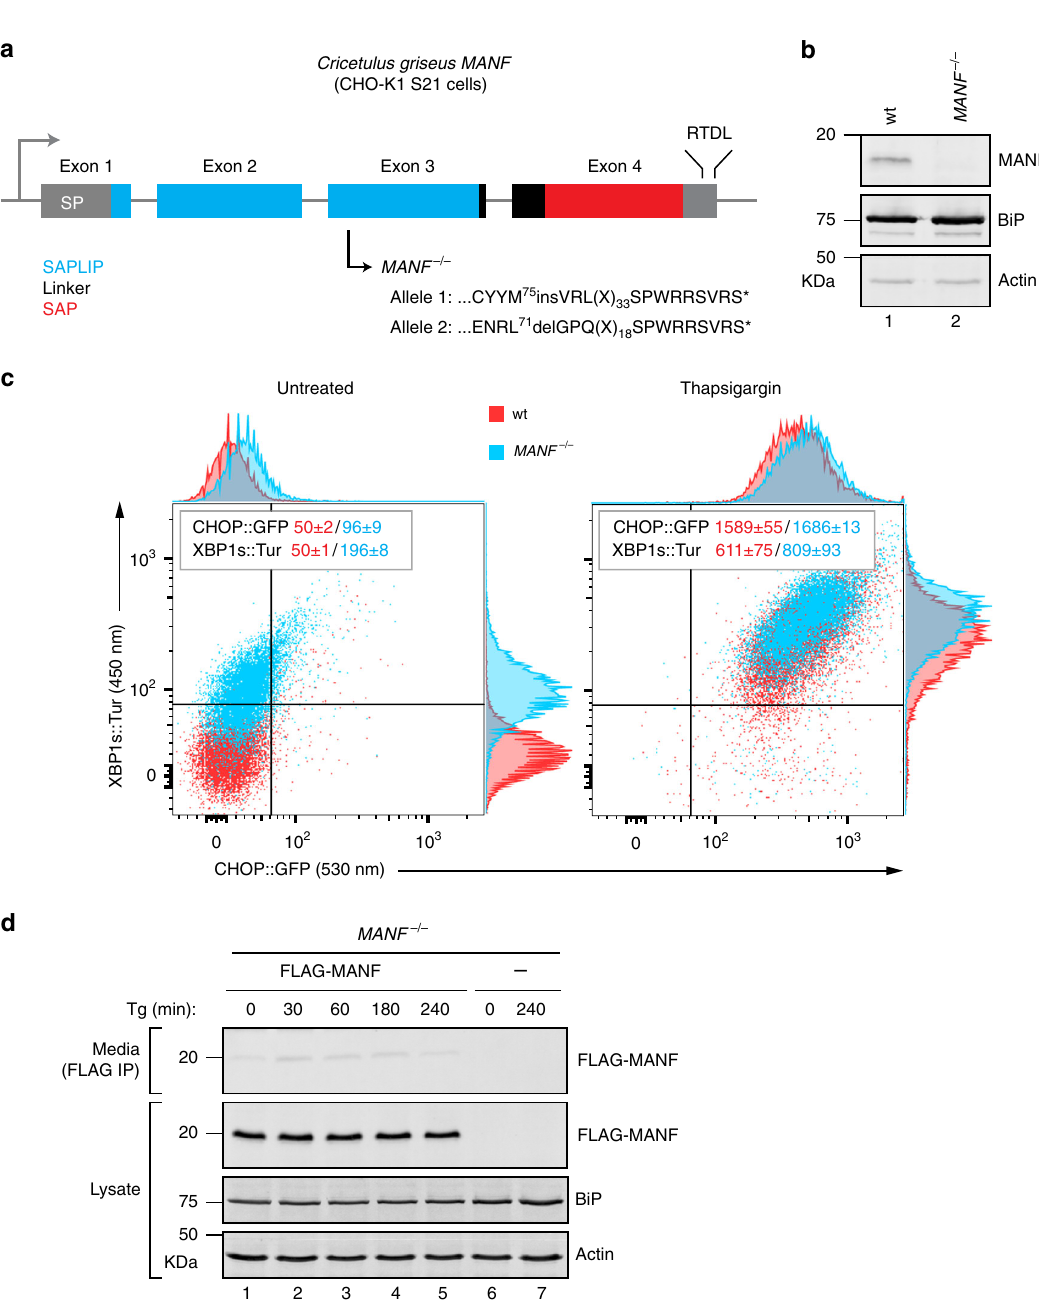
Fig. 1 A heightened UPR in MANF knockout cells. a Schematic illustration of the CHO-K1 MANF gene. The encoded N-terminal SAPLIP (Saposin-like protein; blue) and the C-terminal SAP (SAF-A/B, Acinus, and PIAS; red) domains as well as the signal peptide (SP), linker region (black), and RTDL motif are shown. The encoded amino acid sequence surrounding the mutations (caused by CRISPR-Cas9-mediated nucleotide insertion or deletion) are noted for each allele. Both mutations result in premature termination of translation interrupting the SAPLIP domain and deleting the SAP domain. b Immunoblot of MANF in lysates of CHO-K1 S21 wild-type (wt) and MANF − / − cells. The BiP and actin signal in the samples is also shown. This experiment has been reproduced independently three times. Note that no MANF signal was detected in the sample from MANF -/- cells lysate. c Flow cytometry plots of CHOP: GFP and XBP1s:Turquoise UPR reporters in untreated and thapsigargin-treated (16 h) CHO-K1 S21 wild-type and MANF -/- cells. The inset shows the median ± SD of the GFP and Turquoise fl uorescence signals of the wt (red) and MANF -/- (blue) cells from three independent experiments (similar results were obtained with two independently derived MANF -/- clones). d Immunoblot of FLAG-tagged MANF from cell lysates and FLAG-M1-immunoaf fi nity puri fi ed proteins (FLAG IP) from the corresponding cell culture supernatants (media) of parental CHO-K1 S21 MANF -/- cells and cells stably expressing FLAG-M1- MANF. Cells were untreated or treated with thapsigargin (Tg; 0.5 µ M) for the indicated times. The content of BiP and actin in the samples is provided as a loading control. Uncropped images for panels ( b ) and ( d ) and source data for panel ( c ) are provided as a Source Data fi